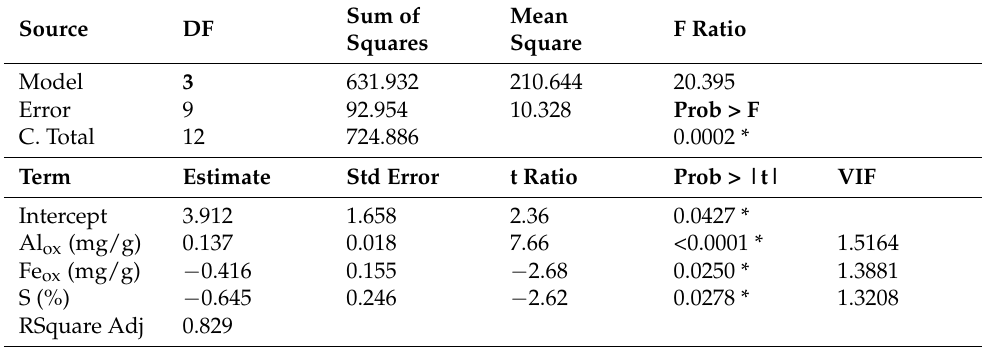
Table 5. Multivariate model between q m and chemical characteristics of